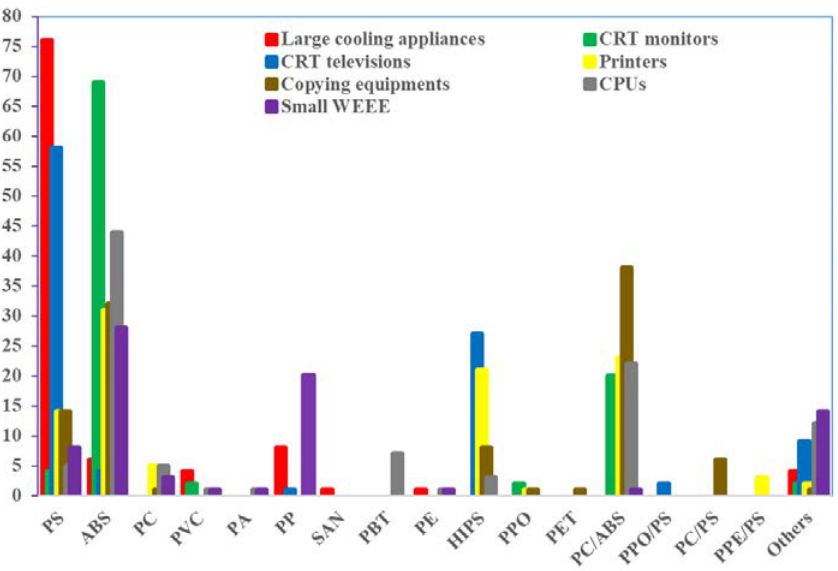
Figure 1. The major plastic polymers used in EEE. Adapted from Ma (2016).